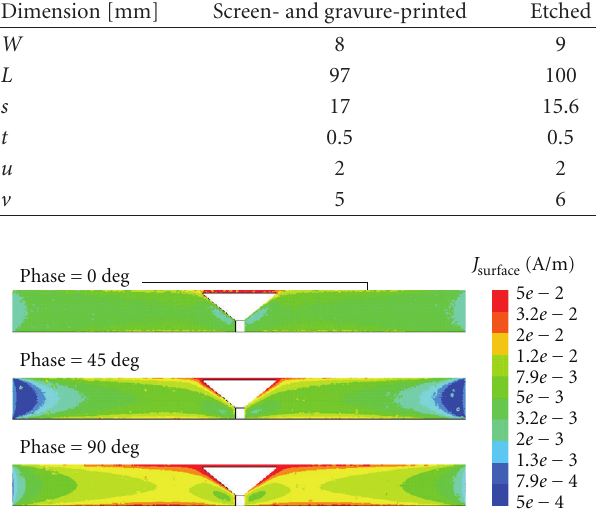
Table 4: The printed samples.